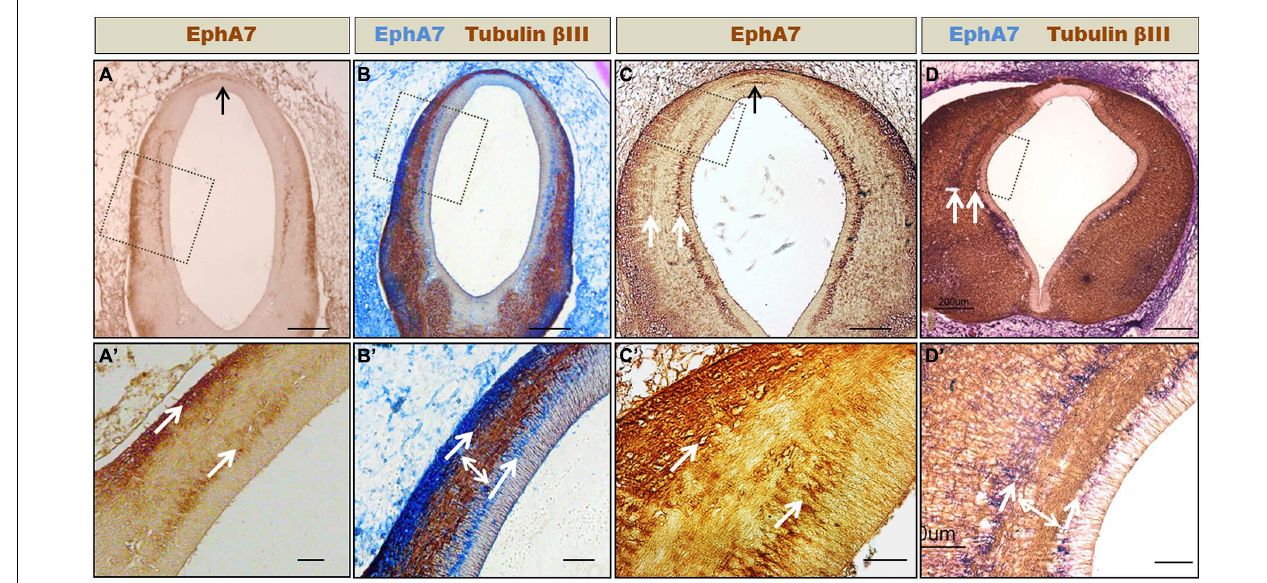
FIGURE 5 | Formation of axonal corridors delimited by EphA7. Frontal sections of HH24 (A,B) and HH30 (C,D) prosomere 1 showing the expression of EphA7 (A,C) and EphA7 and tubulin β III (B,D) . At both stages of development, EphA7 maintains the same expression pattern, with localization at the midline cells of the roof plate (black arrows in A and C ) and in two